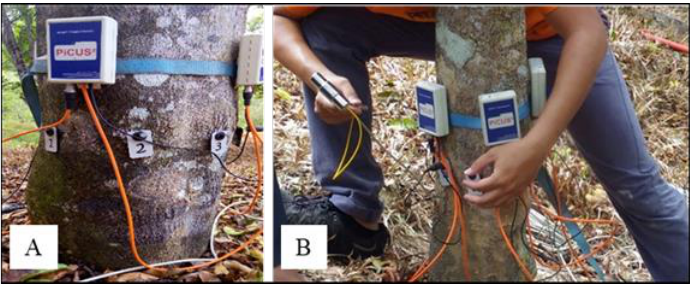
Figure 3. Sound-wave velocity data collected by: ( A ) 6 to 10 sensors vertically near inoculation holes, ( B ) sequentially tapping each nail using an electronic hammer.